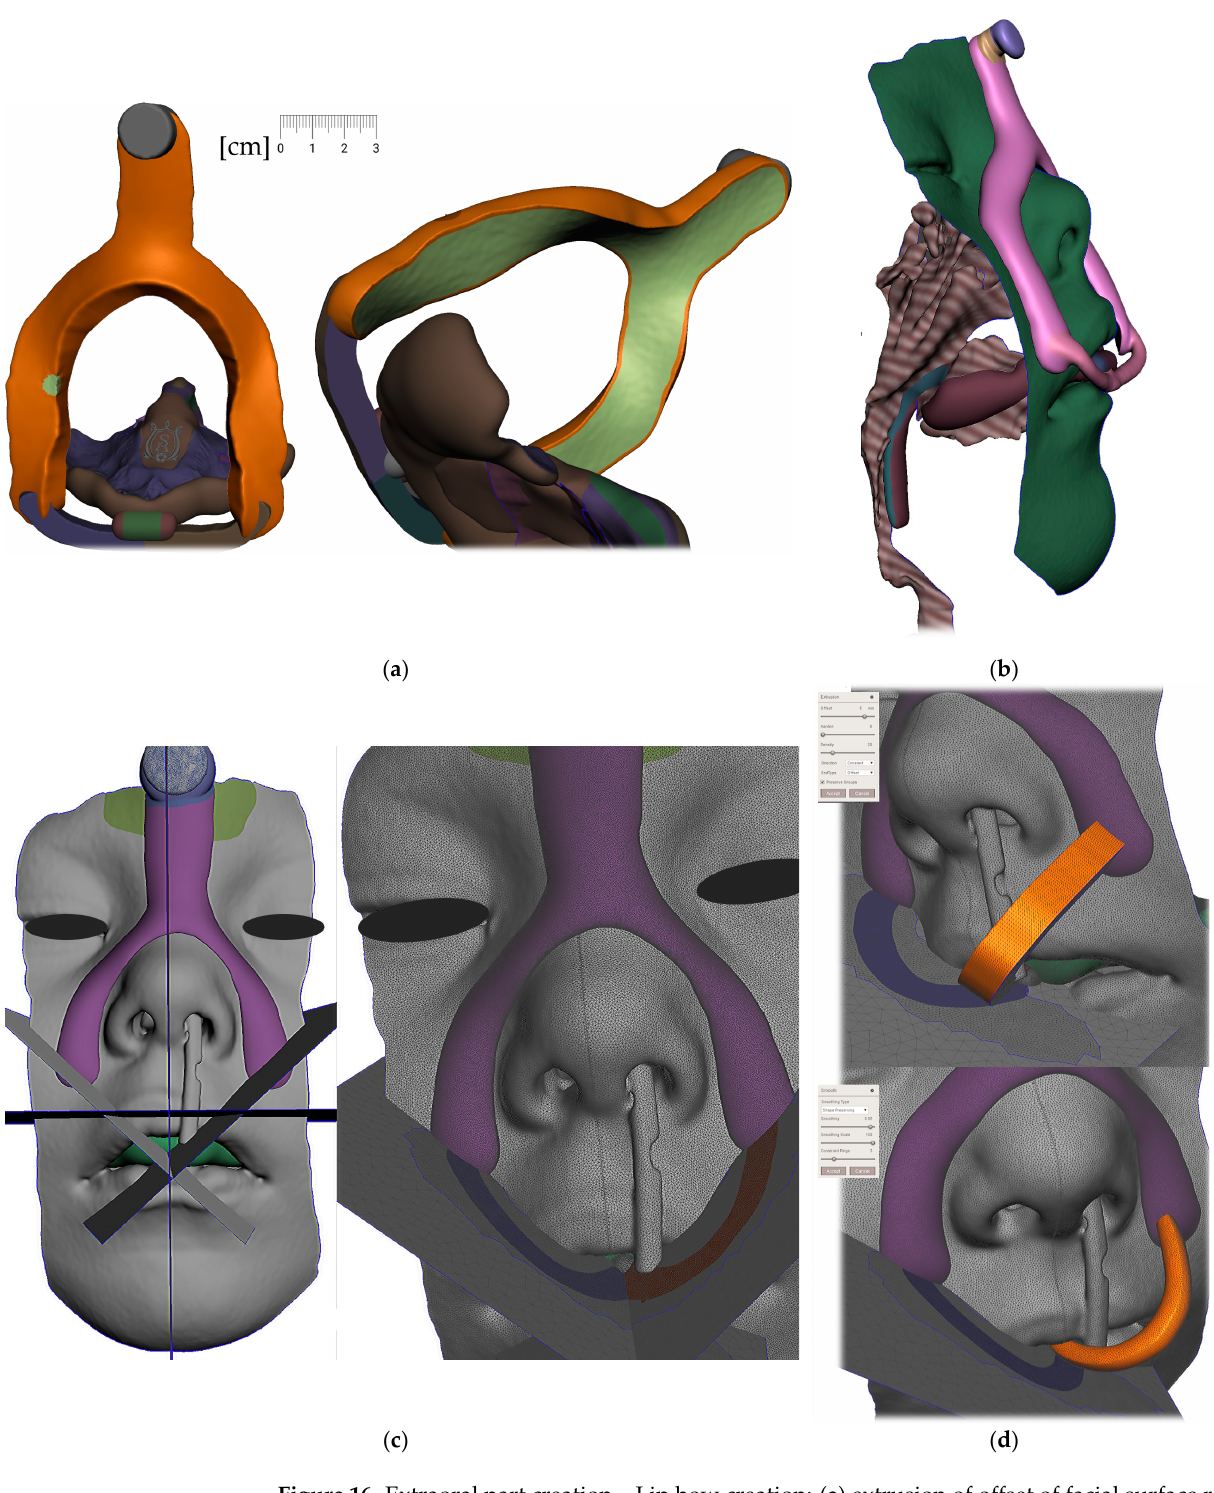
Figure 16. Extraoral part creation—Lip bow creation: ( a ) extrusion of offset of facial surface repre- senting the planned contact with the face followed by smoothing “Ctrl+F” and subsequent extension of the selection keystroke “>” and finished by final smoothing resulting in rounded borders of the extraoral part; ( b ) lateral vied of the variant extraoral part of the appliance; ( c ) Import of mesh 2D plane primitive in 45 ° positioning to allow definition of the labial bow contours; ( d ) extrusion of the contours is followed by smoothing ending in spherical connector to spherical socket.